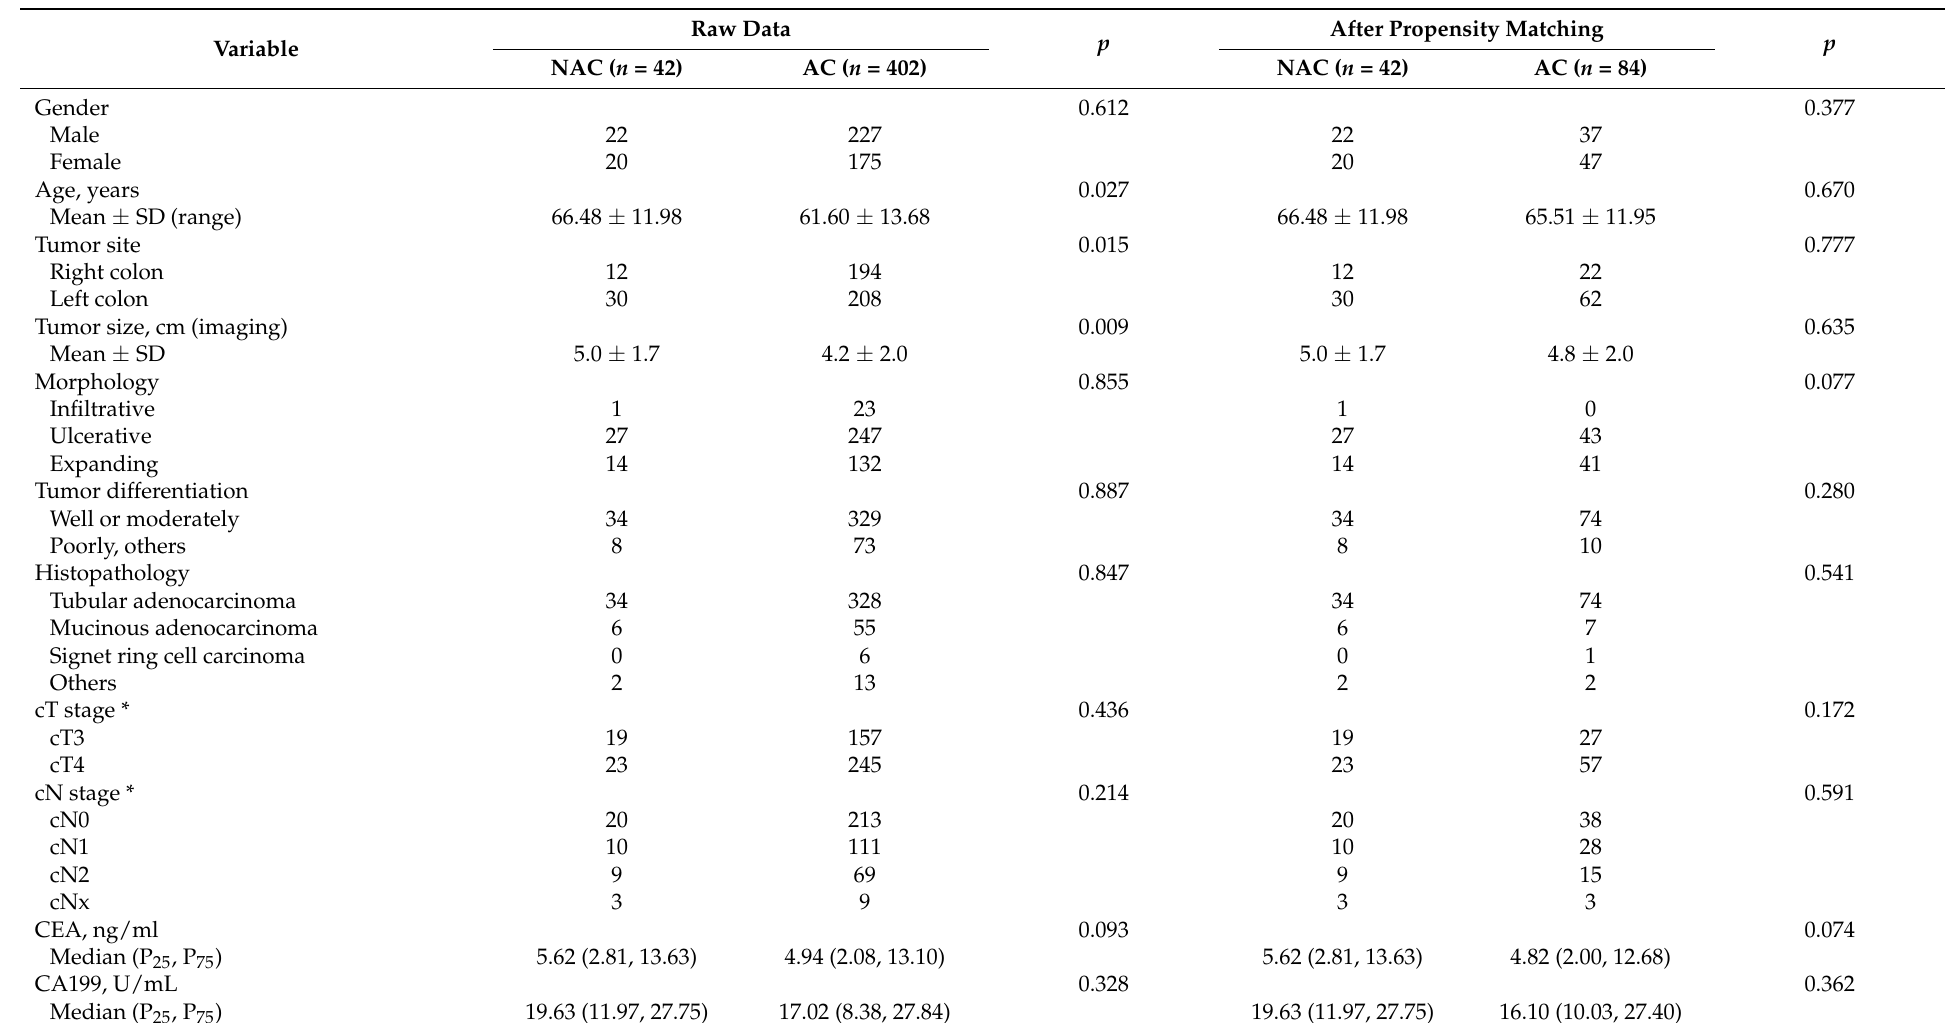
Table 1. Overall patient and tumor characteristics before and after PSM for the NAC and AC